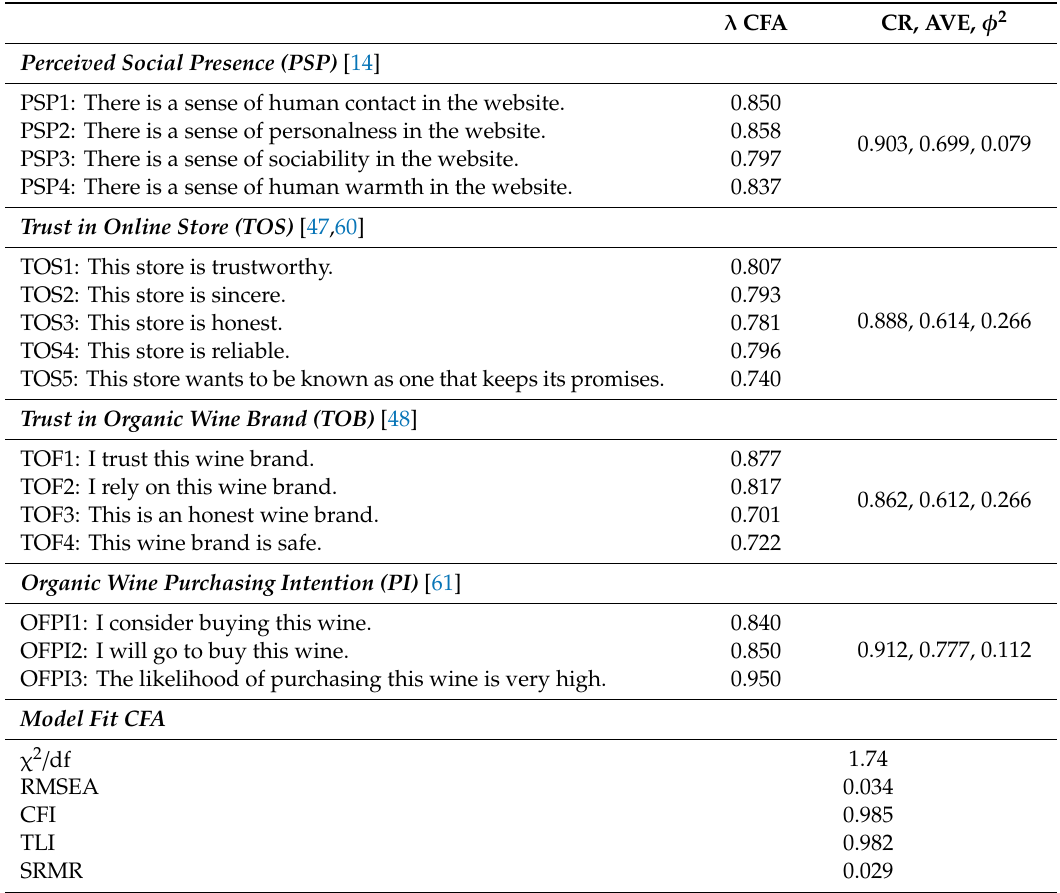
Table 1. Measurement